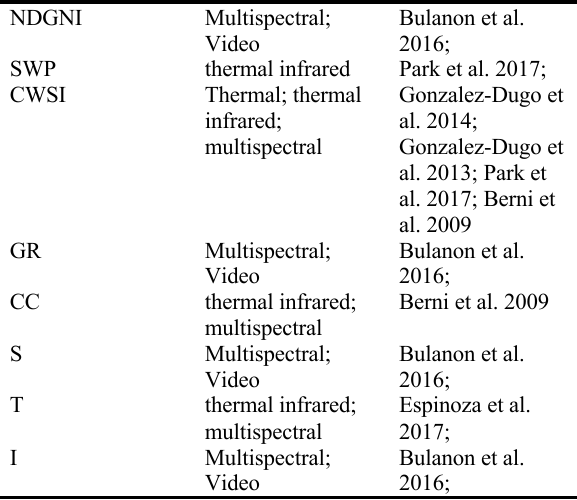
Table 2 - Vegetation Index applied for resource efficiency Employing thermal image processing, such as object-based method, and statistical analysis, applicability and limitation of applying CWSI to indicate water deficits in orchards was demonstrated (Gonzalez-Dugo et al. 2014). After that, three vegetation indices (NDVI,GNDVI, and canopy temperature) show a potential to estimate water status in orchard employing image processing and statistical analysis (Espinoza et al. 2017). In the process of image processing, changing the red band to blue band for NDVI calculation provided a good correlation result, combined with tuning NDVI threshold (Zhao et al.